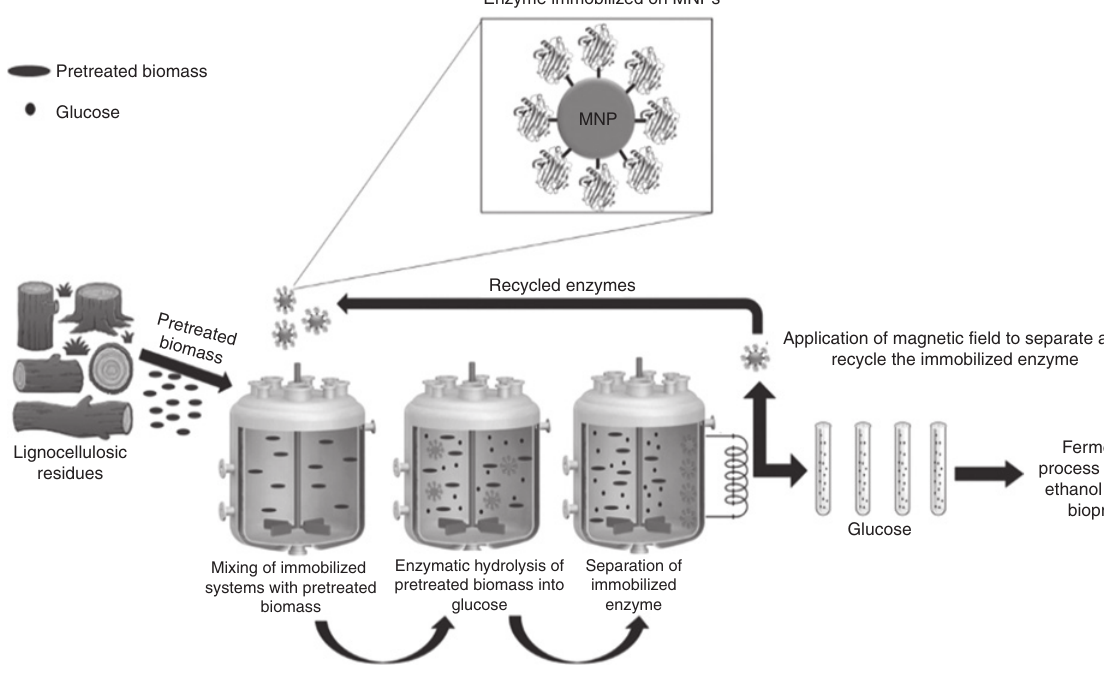
Figure 1: Schematic representation of production of biofuel by the hydrolysis of cellulose from cellulases immobilized using